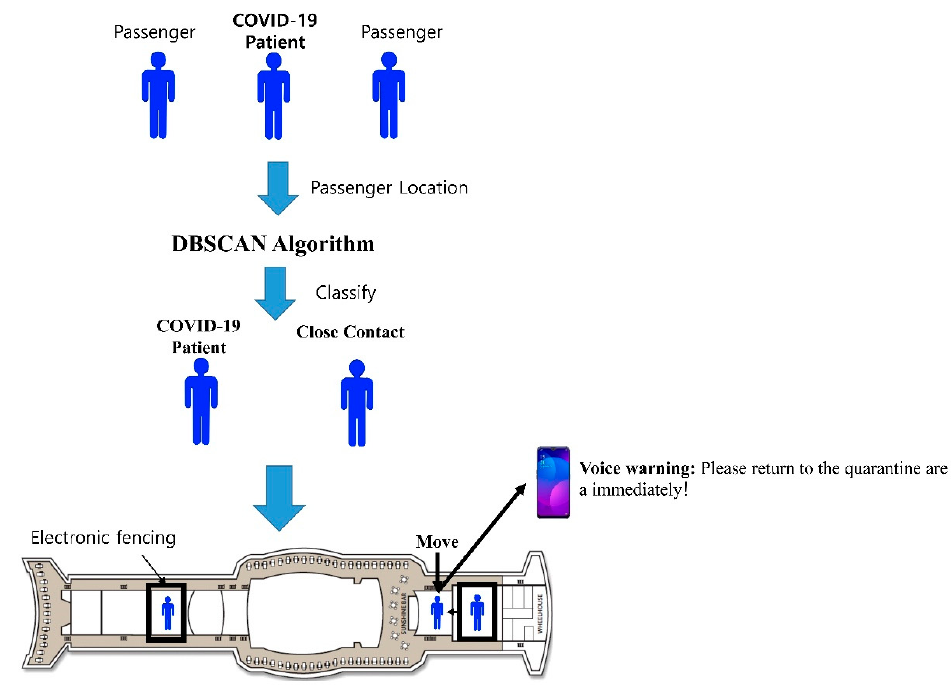
Figure 3. An illustration of how developing technologies can be used to find close contacts [21].